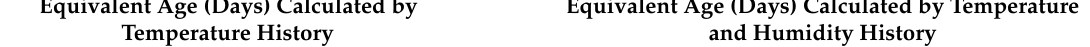
Table 7. Equivalent age calculated by hourly temperature and humidity